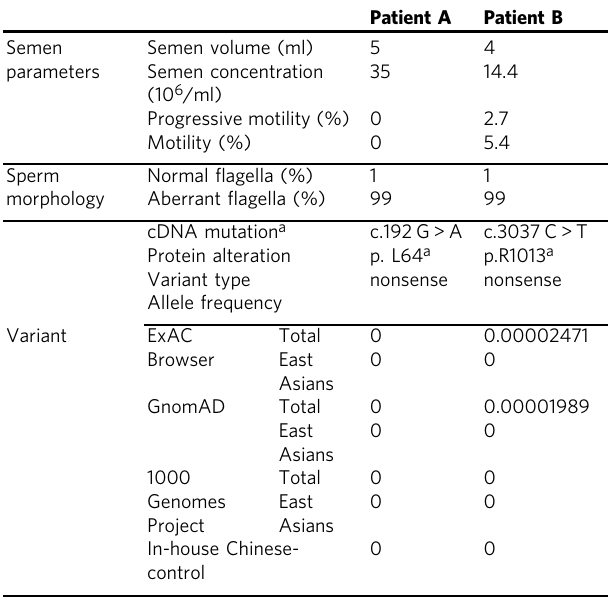
Aberrant fl agellamainlyrepresentmorphologicalabnormalities of the fl agellum includingcoiled, bent, irregular, short or/and absent fl agella a The accession number for QRICH2 is GenBank: